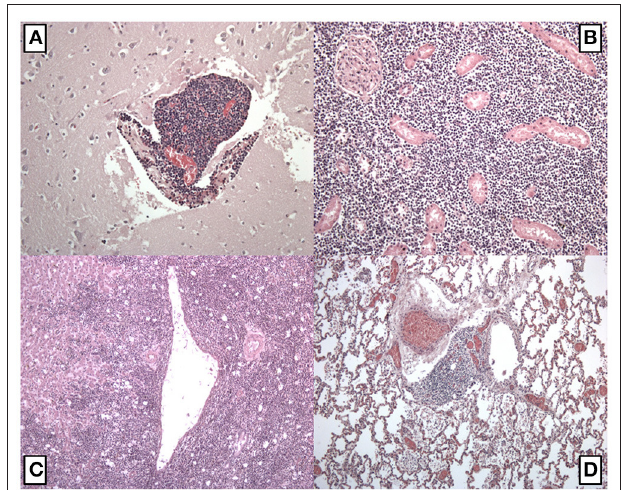
FIGURE 2 | Histological examination after hematoxylin and eosin staining technique. (A) Encephalic samples with a lymph-like structure inside the brain tissue; (B) kidney samples with an area of lymphocytes invasion; (C) liver sample with multiple areas of lymphocytes invasion; (D) lung samples with an area of lymphocytes invasion. In some fields was possible to observe granulocytes infiltration areas.